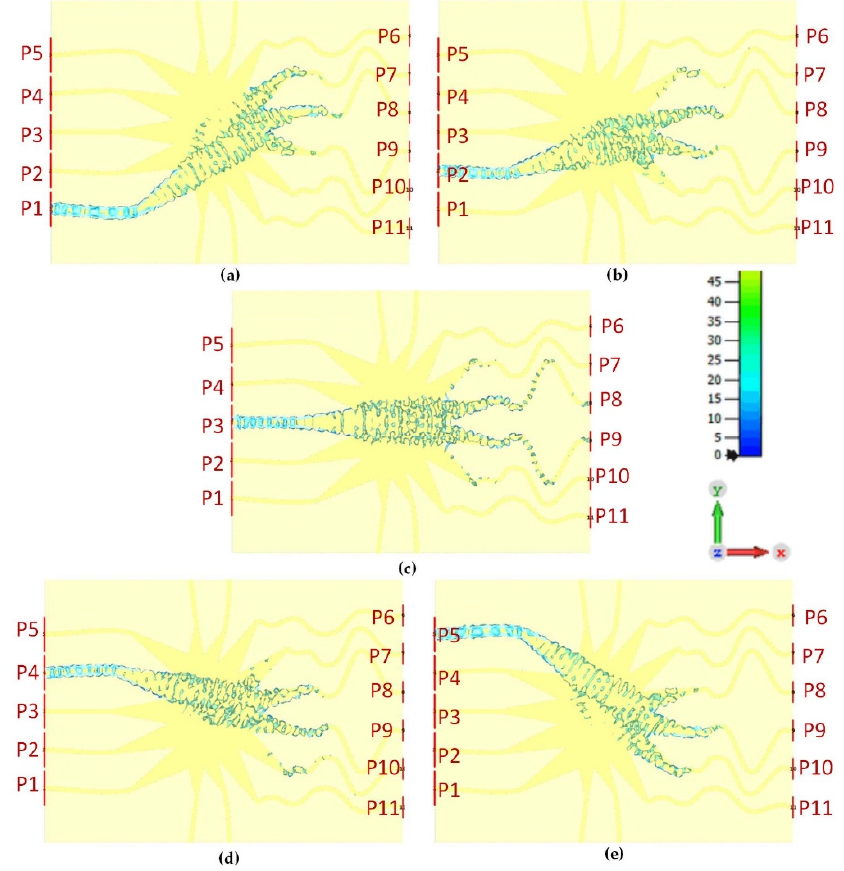
Figure 10. Surface current distributions of the beam port (P1–P5), from below to above, for the proposed Rotman lens sensor; ( a ) P1 is active, ( b ) P2 is active, ( c ) P3 is active, ( d ) P4 is active, ( e ) P5 is active.